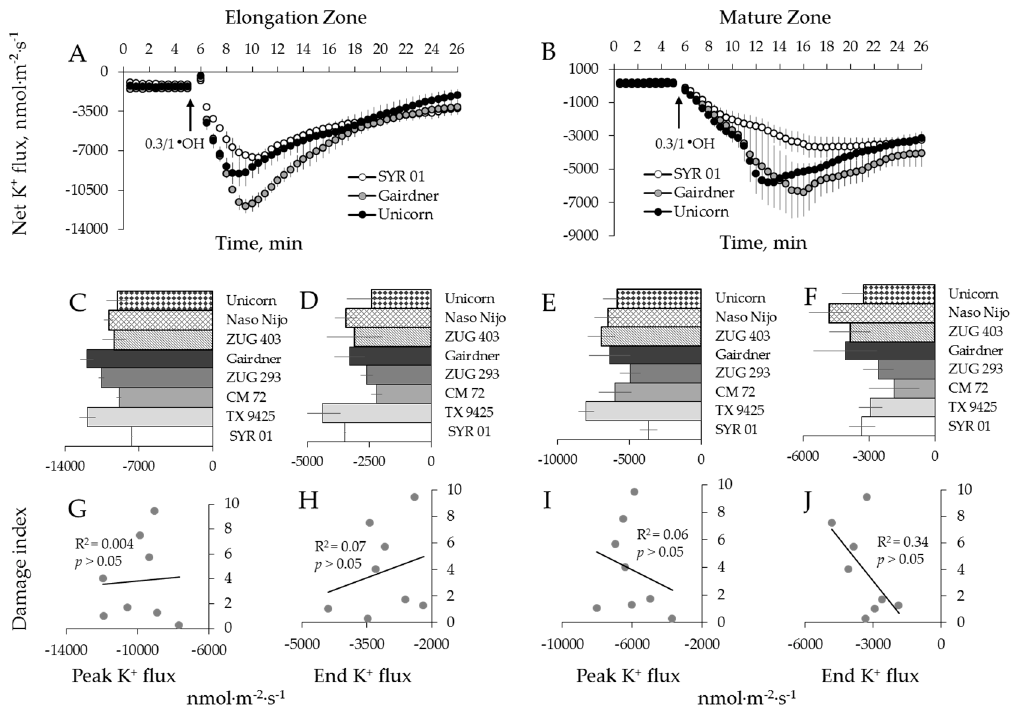
Figure 8. Kinetics of K + fluxes from three representative barley varieties in response to 0.3/1 mM Cu 2+ /ascorbate mixture ( ● OH) treatment from both root elongation zone ( A ) and mature zone ( B ). Error bars are means ± SE ( n = 6–8). ( C , D , G , H ) Peak ( C ) and end ( D ) K + fluxes of eight barley varieties in response to ● OH and their correlation with damage index ( G , H , respectively) in root elongation zone. ( E , F , I , J ) Peak ( E ) and end ( F ) K + fluxes of eight barley varieties in response to ● OH and their correlation with damage index ( I , J , respectively) in root mature zone.